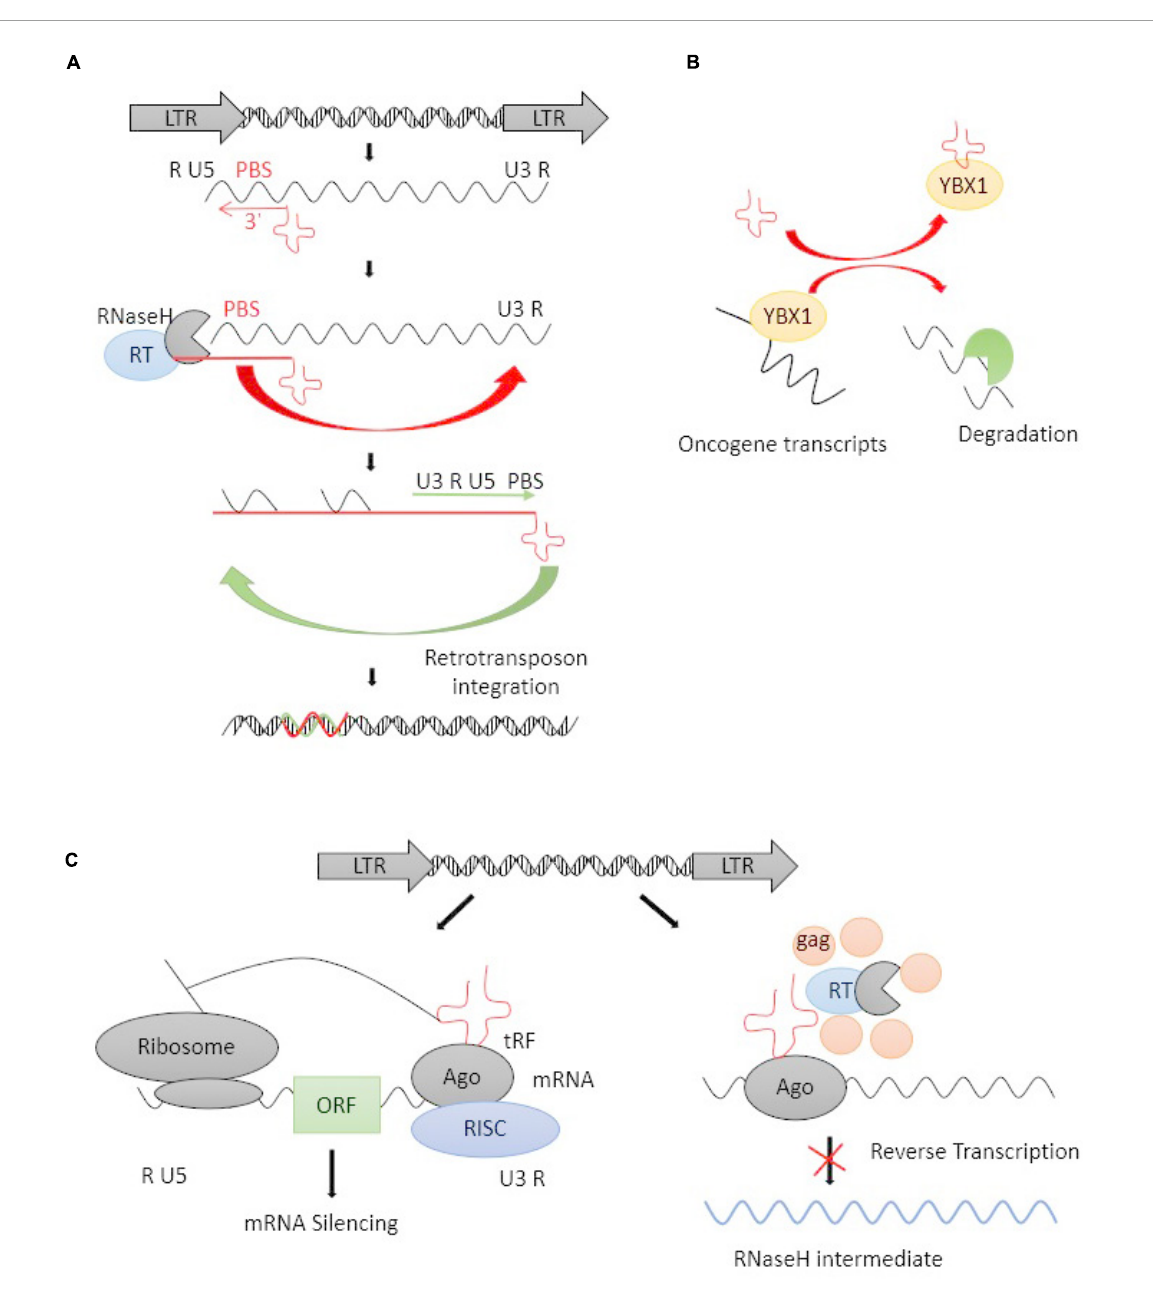
at the RT step by targeting the PBS sequence. Schorn et